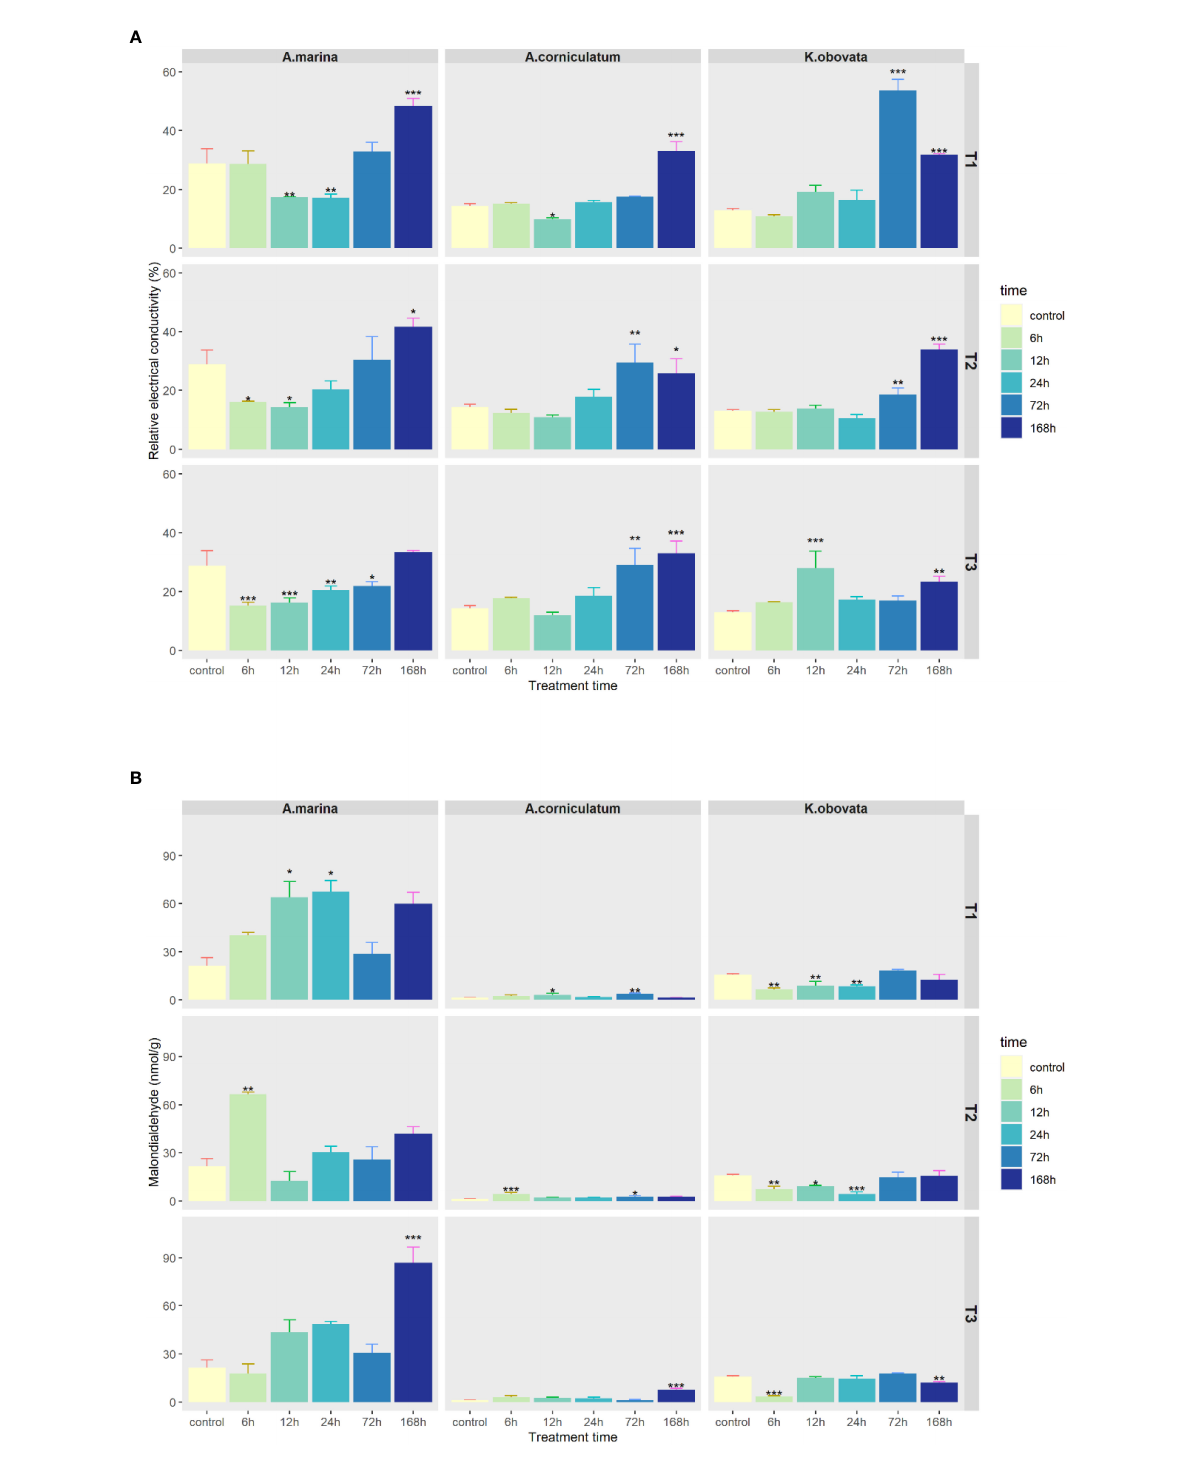
FIGURE 2 Changes of (A) Relative electrical conductivity and (B) Malondialdehyde content under upwelling stress. * indicates that there are signi fi cant differences between control and treatment groups (p<0.05(*), p<0.01(**), p<0.001(***)). “ T1 ” means 5°C upwelling stress, “ T2 ” means 10°C upwelling stress and “ T3 ” means 15°C upwelling